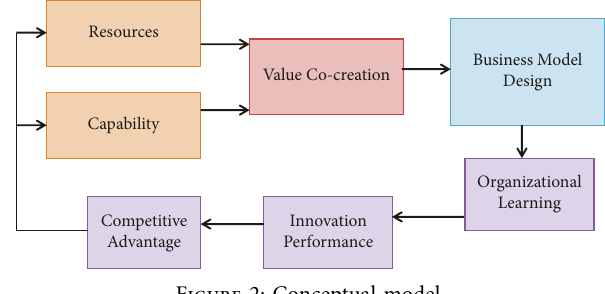
Figure 2: Conceptual model.